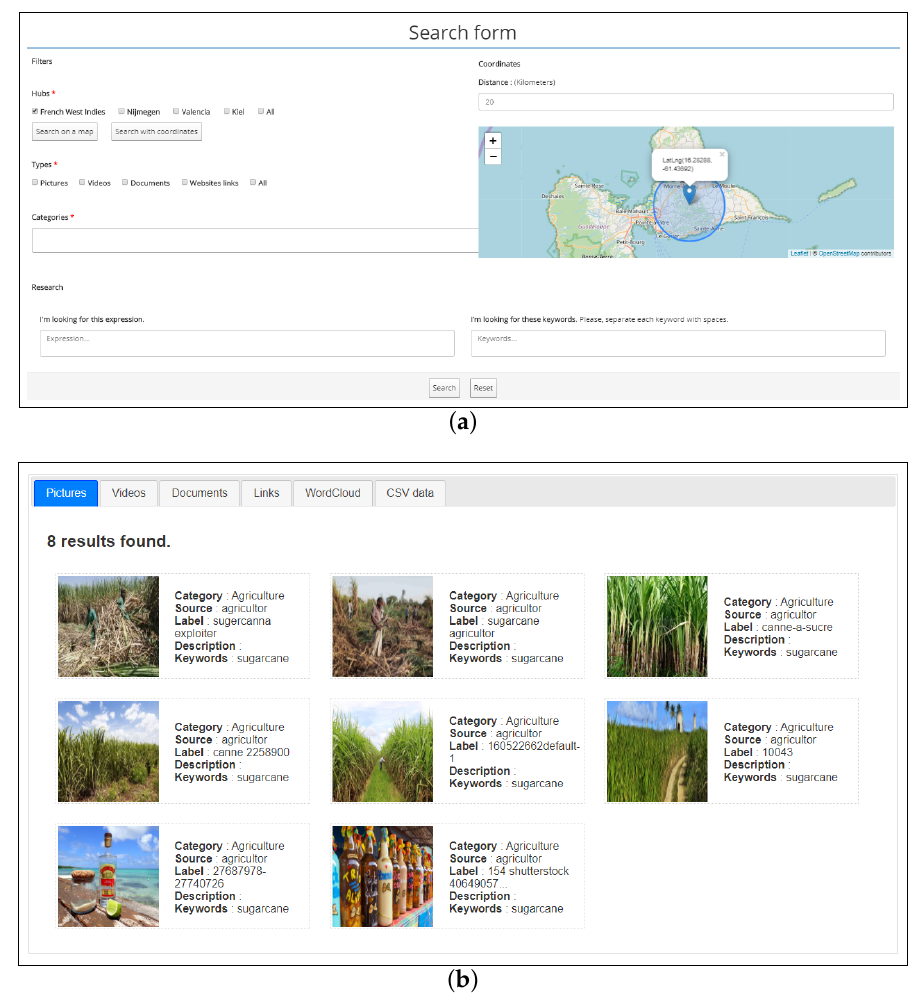
Figure 9. Research on DKP with ( a ) research form and ( b ) example of results with terms “sugar” and